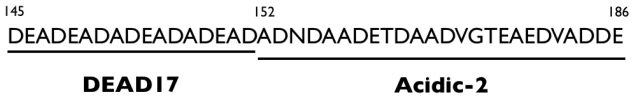
C-terminal 42 amino acid domain of Asprich “a” through “g” proteins. The two derived polypeptides (DEAD17, Acidic-2) that comprise this C-terminal domain are shown.